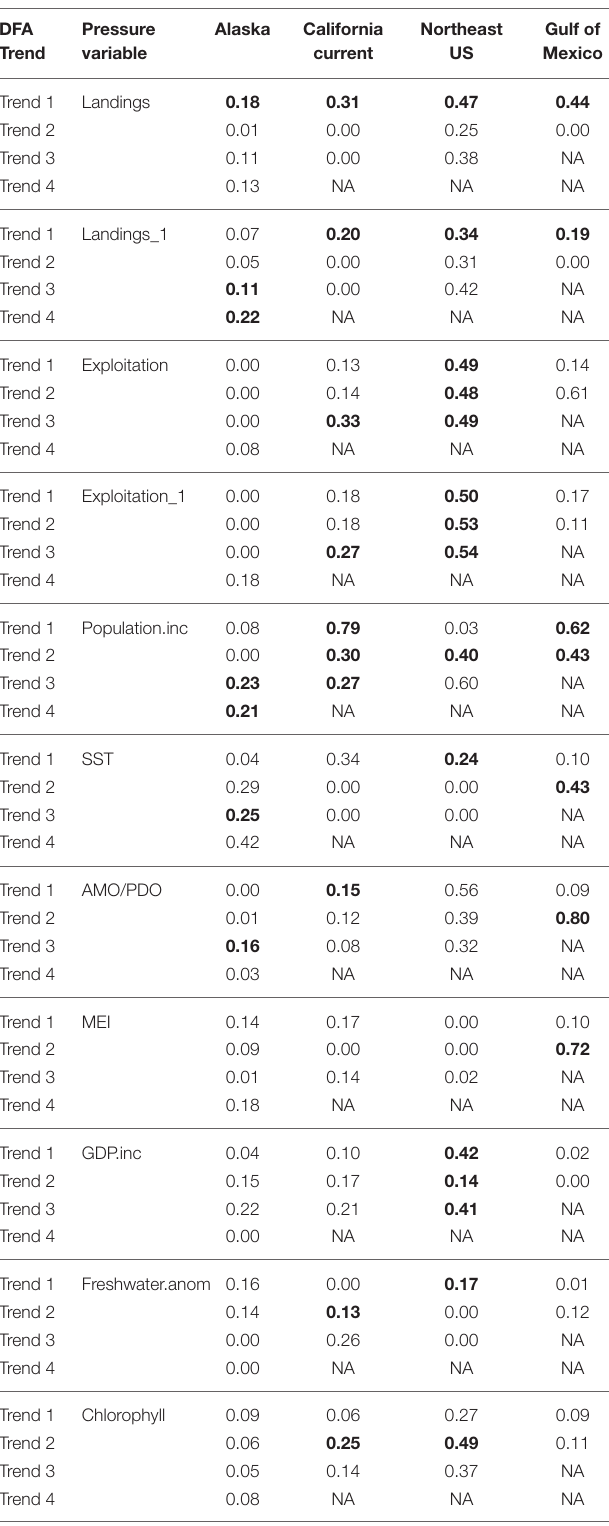
TABLE 4 | Deviance explained for the generalized additive model results for each ecosystem trend (DFA Trend) and pressure variable (using variables common in all